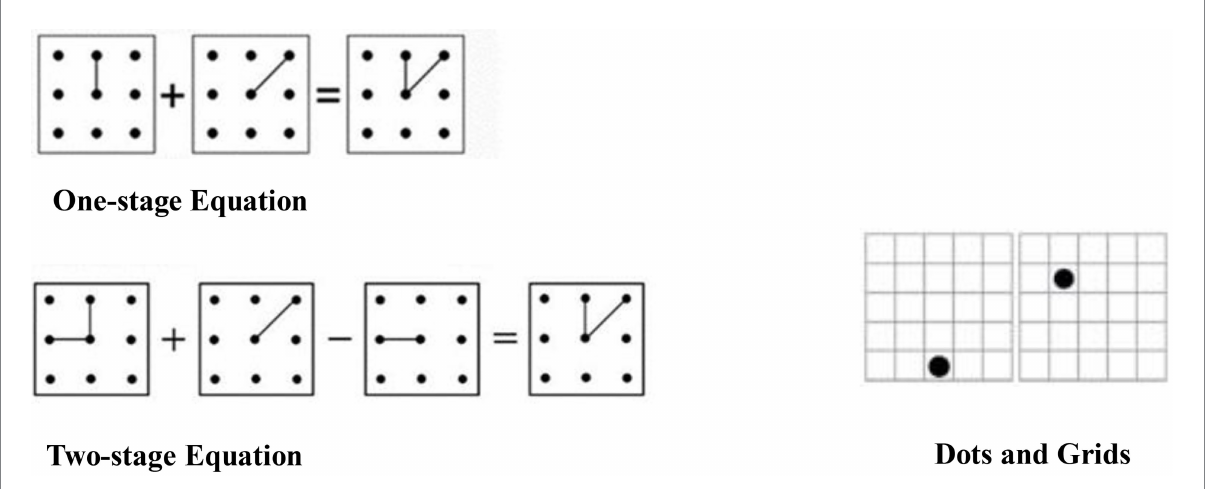
FIGURE 1 Illustration of stimulus in the spatial equation matrix and dot memory